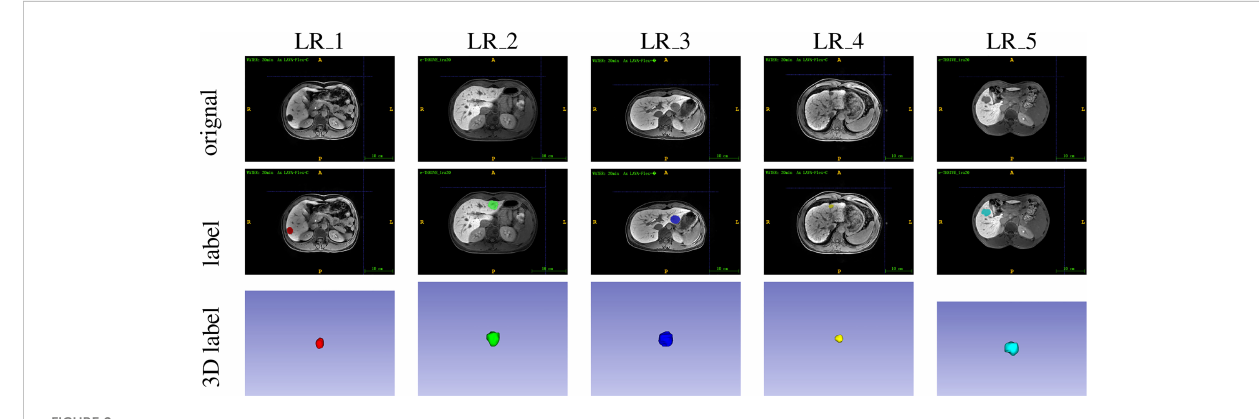
FIGURE 2 The segmentation and grading results of representative images.